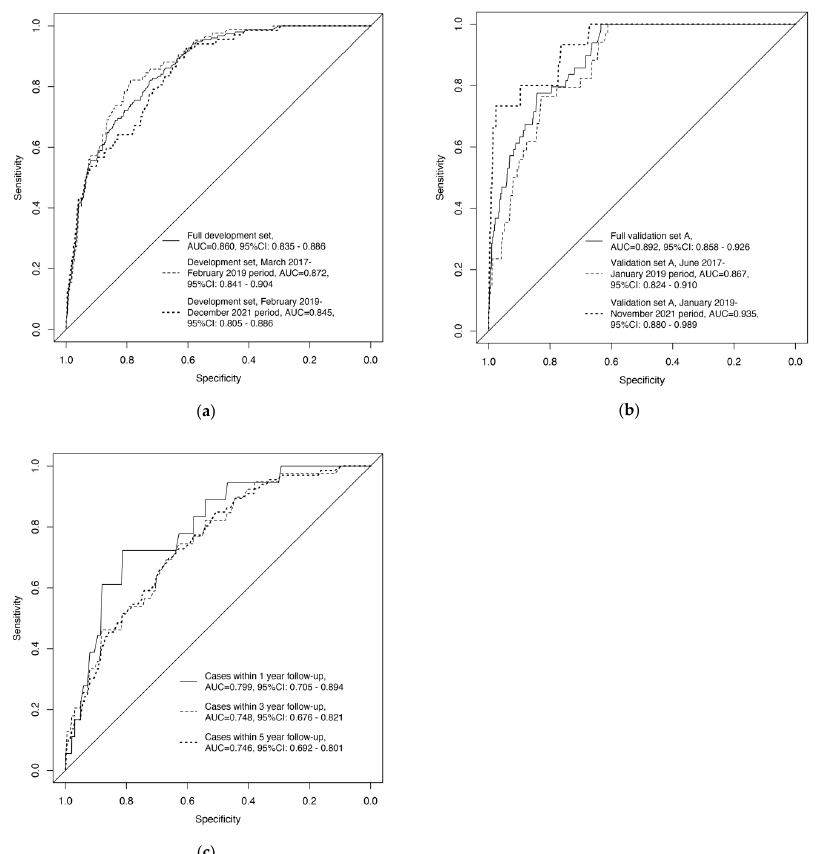
Figure 1. Receiver operating characteristic curves of the improved prediction model for severe dysplasia and above in ( a ) the development set, ( b ) the validation set A, and ( c ) the validation set B. AUC, Area under the curve; CI, confidence